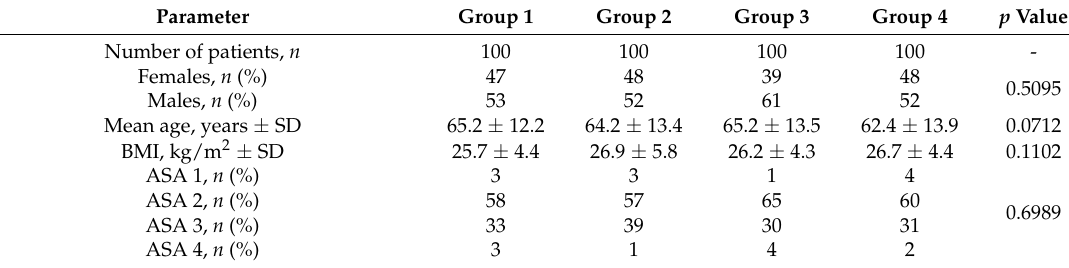
Table 1. Demographic analysis of patient